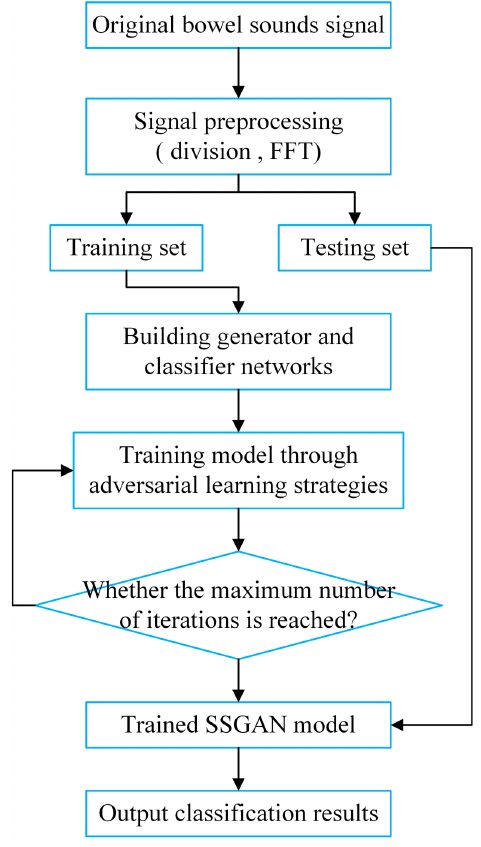
Figure 1. Flowchart of the proposed method.